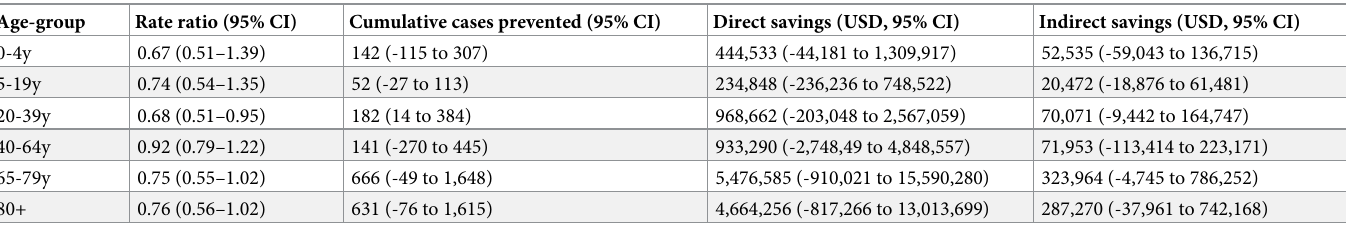
Table 4. The posterior median of the rate ratio between observed and predicted number pneumonia hospitalisations during the post-vaccine period (2013–2017).